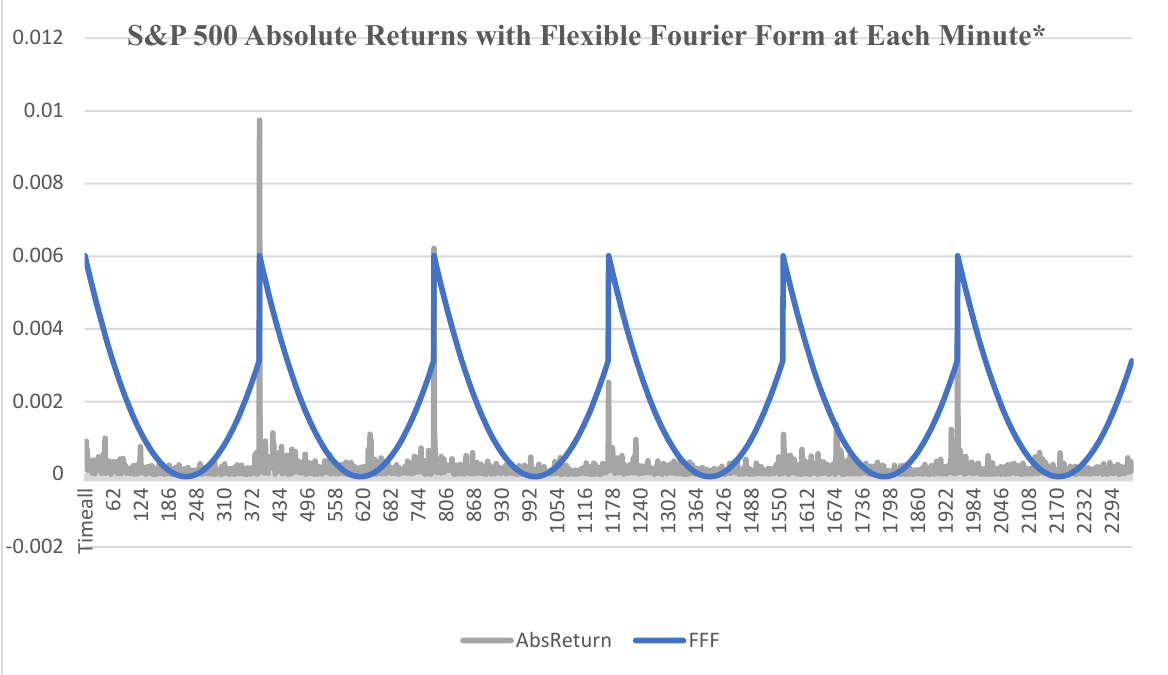
Figure 1. S&P 500 Absolute Returns and Flexible Fourier Form, * observation days were 2–9 January